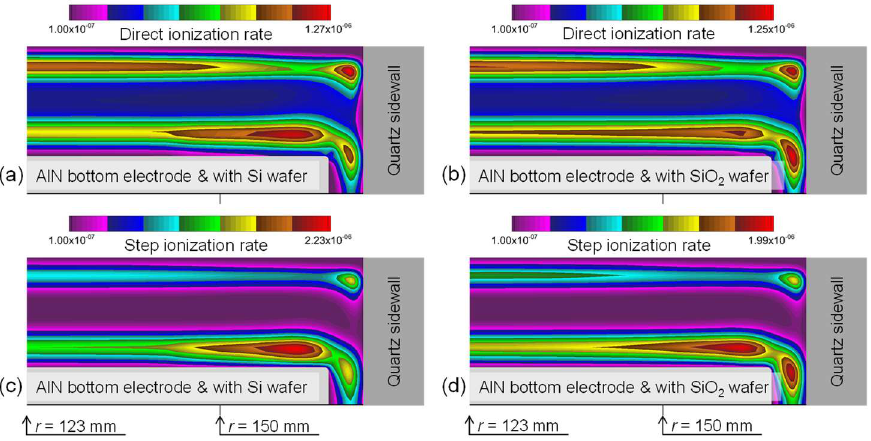
Figure 3. Effects of the dielectric constant of the wafer on the spatial distribution of the plasma parameters. Contour plots for the spatial profiles of the time-averaged SiH 2+ production rate (kmol·m −3 ·s −1 ) for ( a ) Case 4 and ( b ) Case 5 for r ≥ 123 mm. Contour plots for the spatial profiles of the time-averaged Si + production rate (kmol·m −3 ·s −1 ) ( c ) for Case 4 and ( d ) for Case 5 for r ≥ 123 mm. The profiles are radially uniform for r < 123 mm.